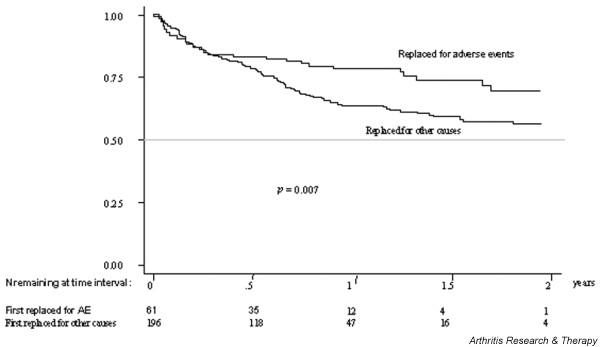
Survival of the second tumor necrosis factor (TNF) antagonist depending on the reason of replacement of first treatment. The numbers under the curves represent the patients known to be still on treatment by the end of the interval. Differences in the number between intervals do not mean that patients failed (stopped TNF antagonist). They actually represent the patients known to be still on treatment as of the time marked. AE, adverse effect.